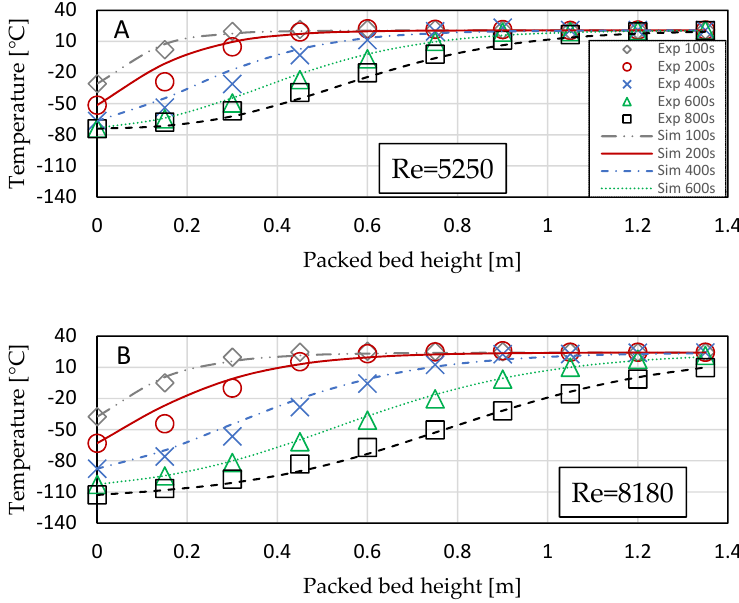
Figure 8. Experimental and predicted temperature front comparisons at different Reynolds numbers, Re = 5251 and Re = 8179. Packed bed filled with 20 mm quartzite gravel.